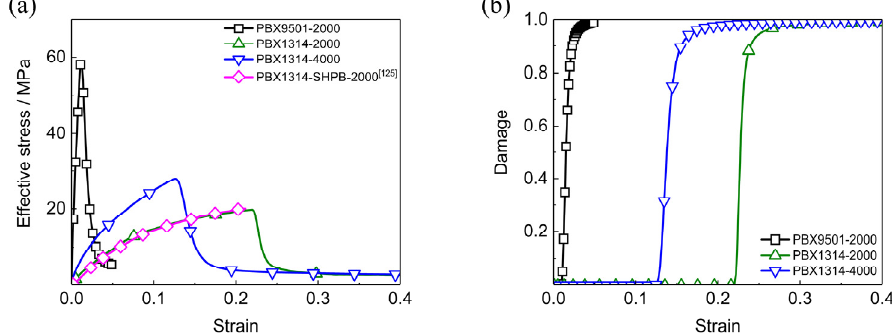
Figure 3. Dynamic mechanical responses of PBX1314 and PBX9501 under uniaxial compressions. ( a ) Stress–strain curves, ( b ) damage–strain curves.